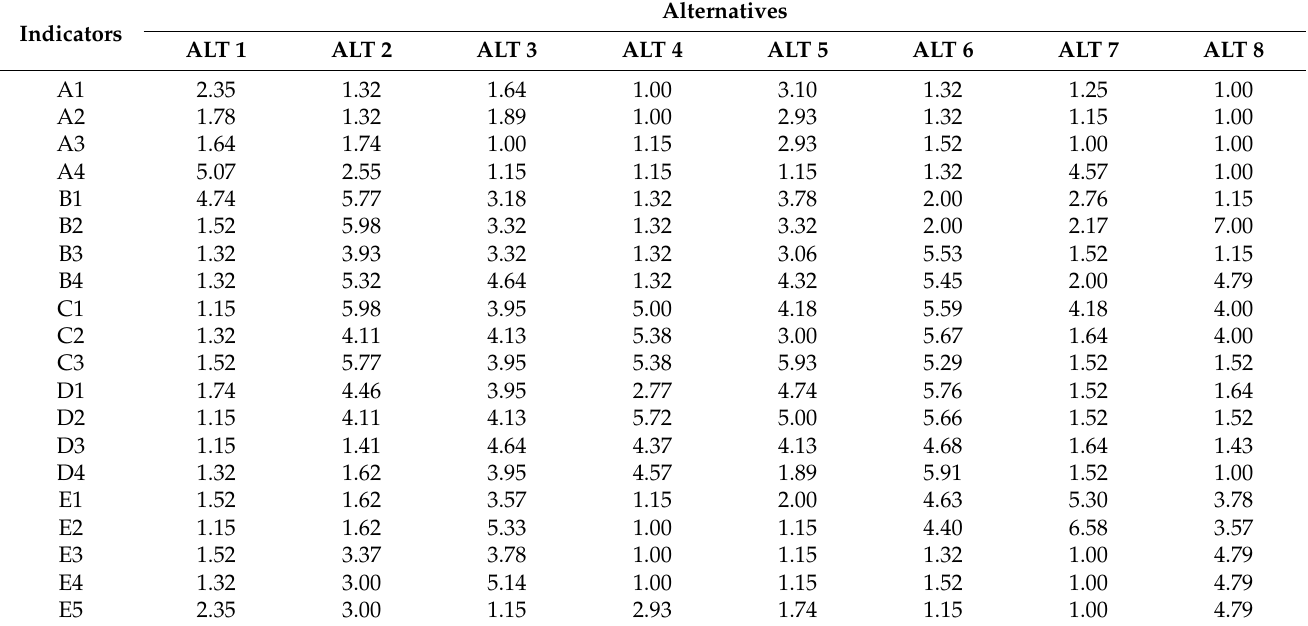
Table 13. Decision matrix for each alternative with respect to each